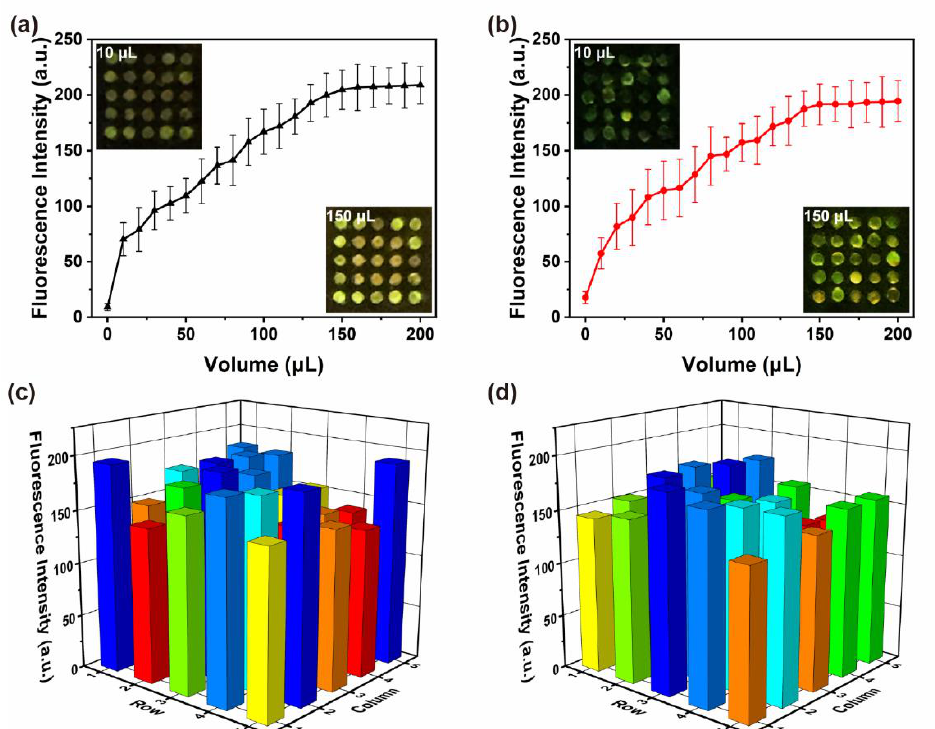
Figure 6. The average fluorescent intensity of ( a ) concave-up frustules and ( b ) convex-up frustules. The fluorescence intensity distribution of 25 frustules of ( c ) concave-up orientation and ( d ) convex-up orientation.